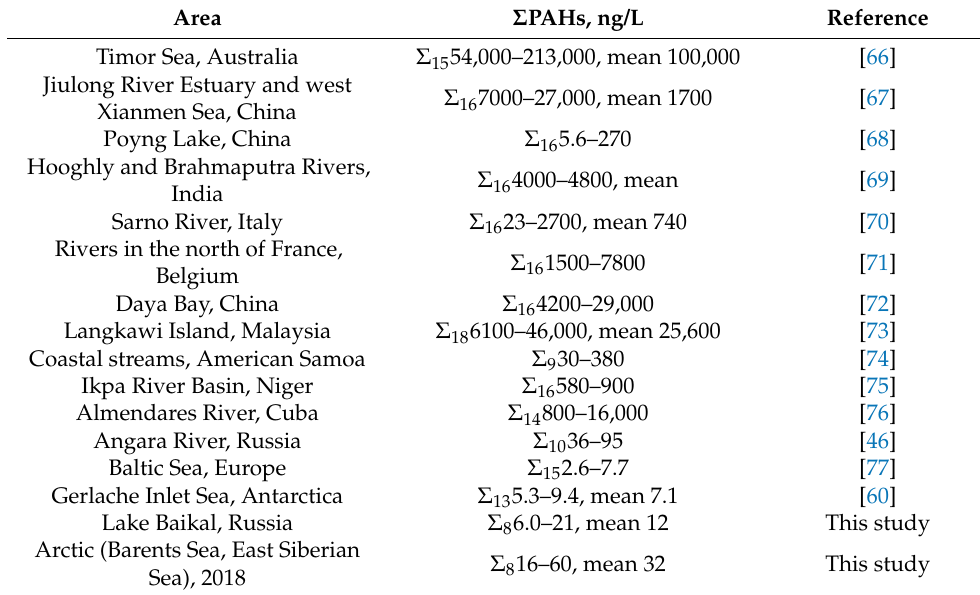
Table 1. PAH concentration in the surface waters of the